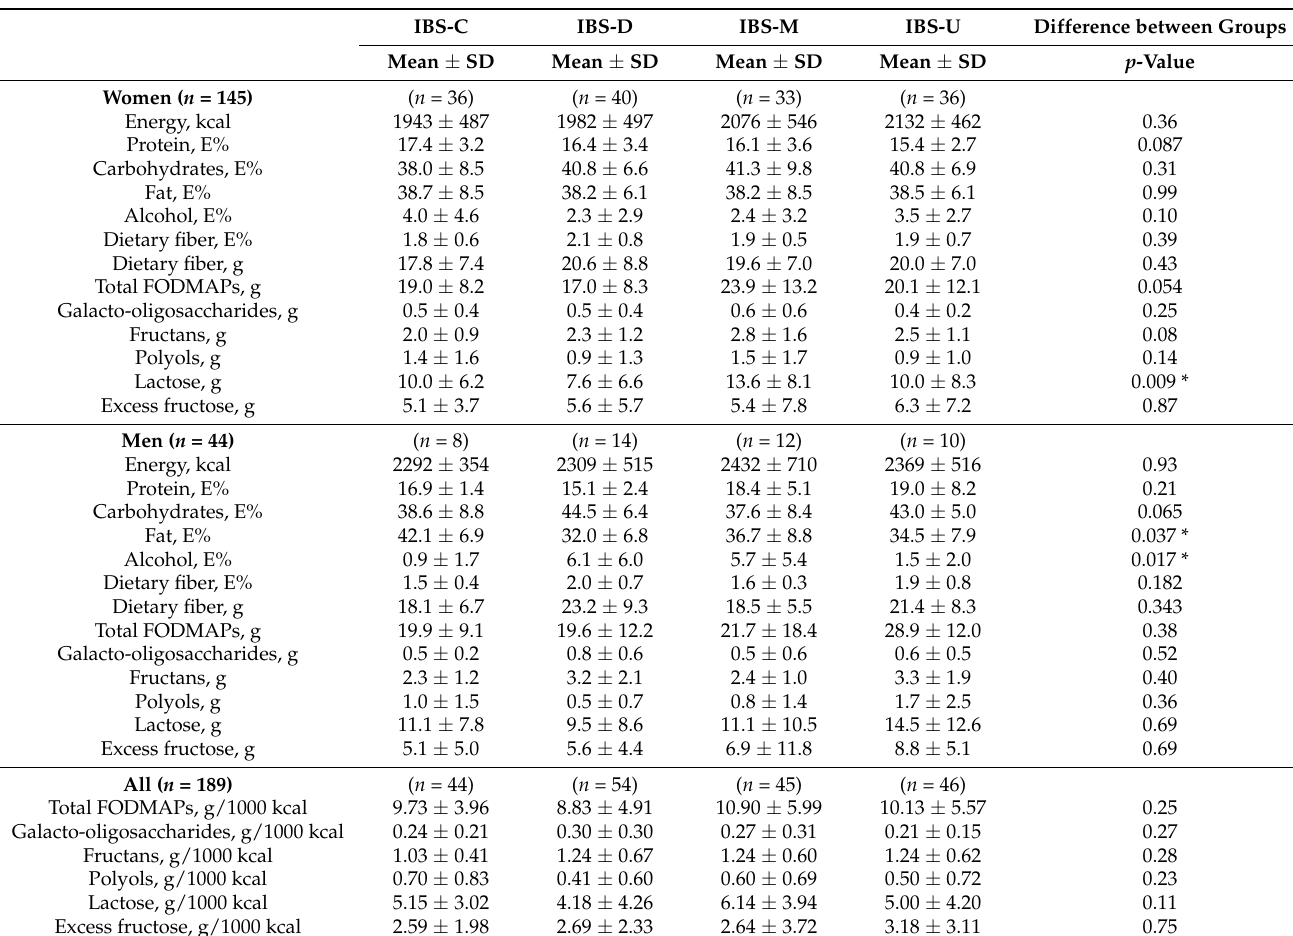
Table 2. Average reported daily energy, macronutrient, dietary fiber, and FODMAP intake among women and men with irritable bowel syndrome, divided into subtypes of IBS.